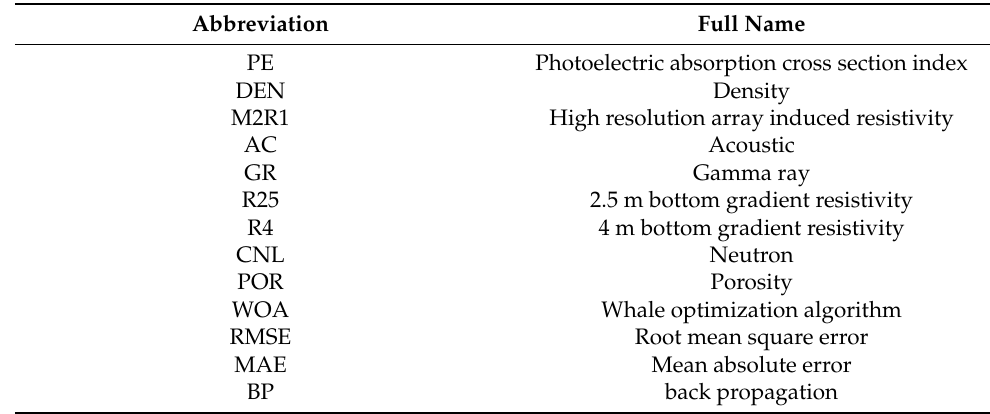
Table 1. The full name of the abbreviation mentioned in the